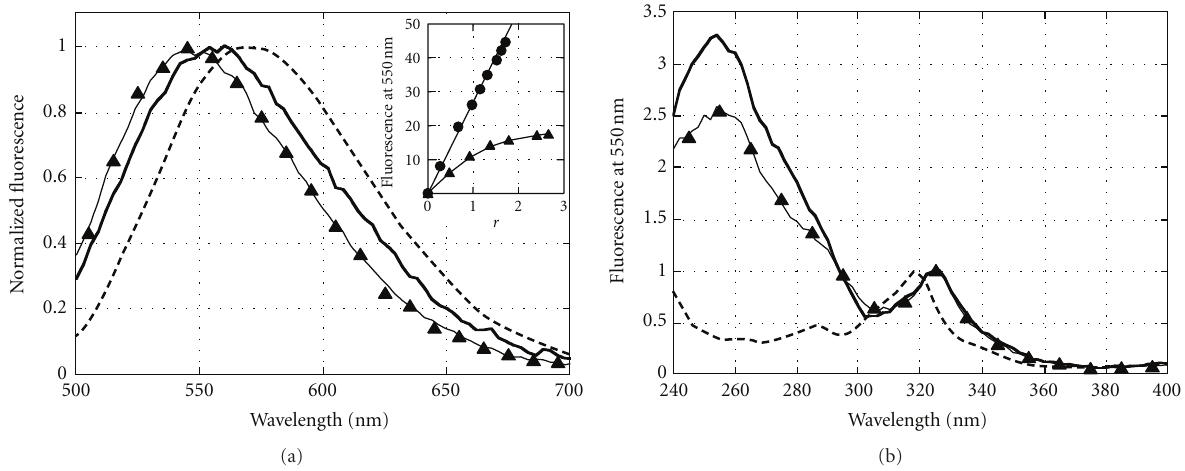
Figure 4: Fluorescence of AIC:G-quadruplex complexes. (a) The fluorescence spectra of free AIC in 95% ethanol solution (dashed line), AIC bound to Pu18 G-c- Myc (solid line) and to G-tel (triangles). The intensity of fluorescence was registered after excitation at 320nm and normalized to 1. The parameter r was ∼ 1 for all complexes. Inset: fluorescence of AIC:G-quadruplex complexes depending on r . Complexes AIC:G-c- Myc (triangles), AIC:G-tel (circles). (b) Excitation spectra of complexes AIC:G-c- Myc (solid line), AIC:G-tel (triangles), and free AIC in 95% ethanol solution (dashed line). Fluorescence intensity I 550 registered at 320nm was normalized to 1. The numbers of bound AIC molecules per G-c- Myc and G-tel were r = 1.